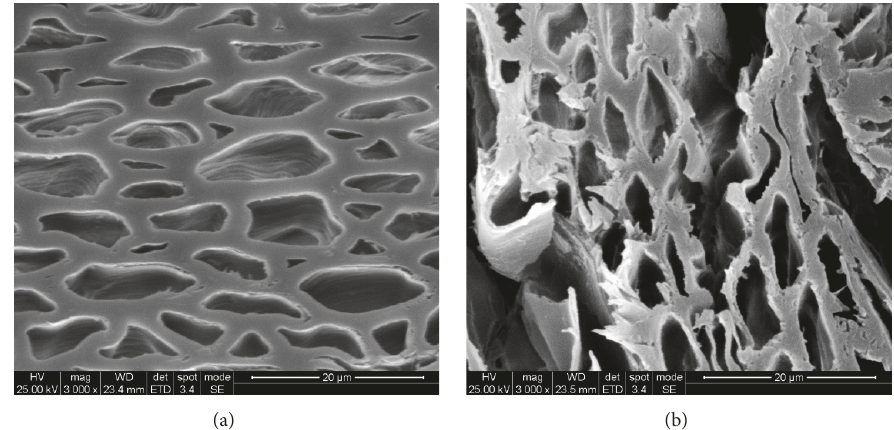
Figure 10: SEM images of the cross-sectional surfaces of mulberry branch fibers without and with xylanase pretreatment. (a) Control sample (without xylanase pretreatment). (b) Sample with xylanase pretreatment (enzyme dosage, 20